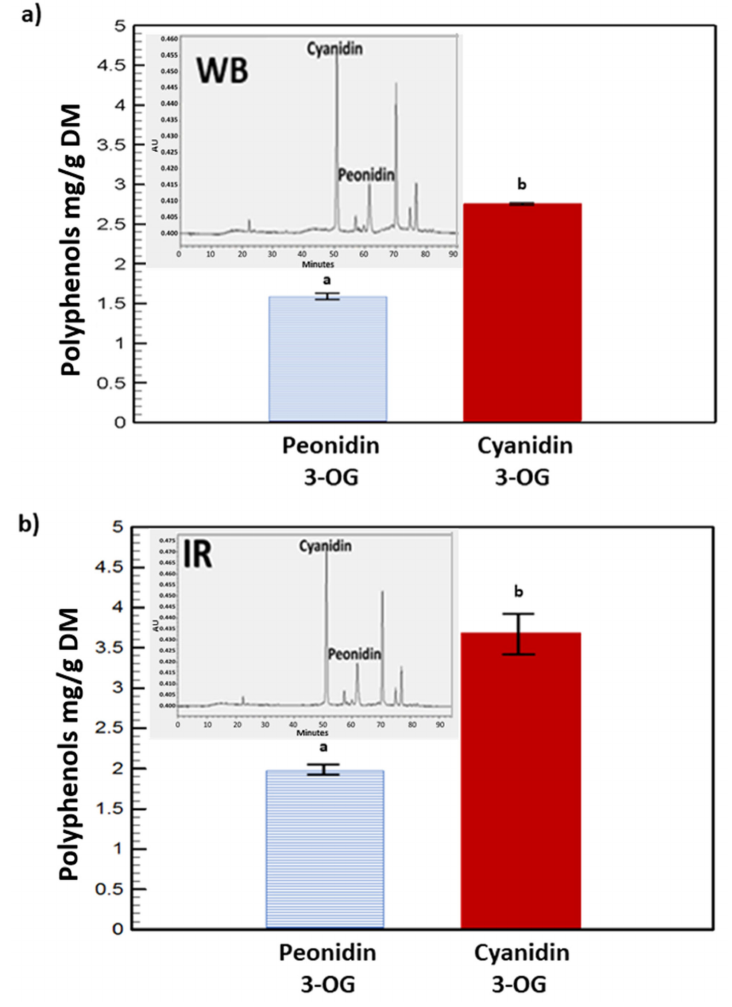
Figure 6. HPLC analyses of peonidin 3-O-glucoside and cyanidin 3-O-glucoside in WB ( a ) and the IR ( b ) extracts. Different letters (a,b) indicate signficant